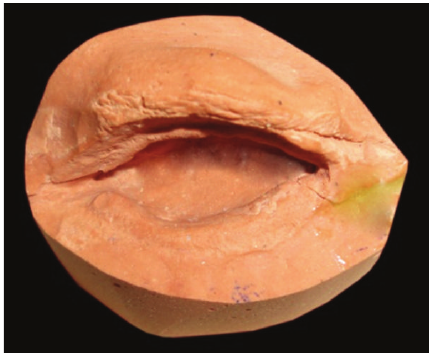
Figure 2: Two-piece dental cast.